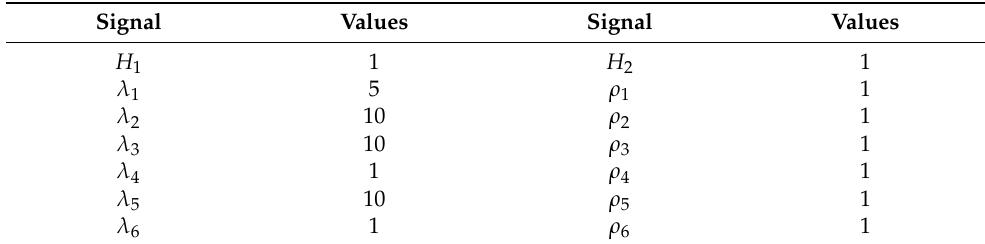
Table 1. Design parameters of disturbances observer.